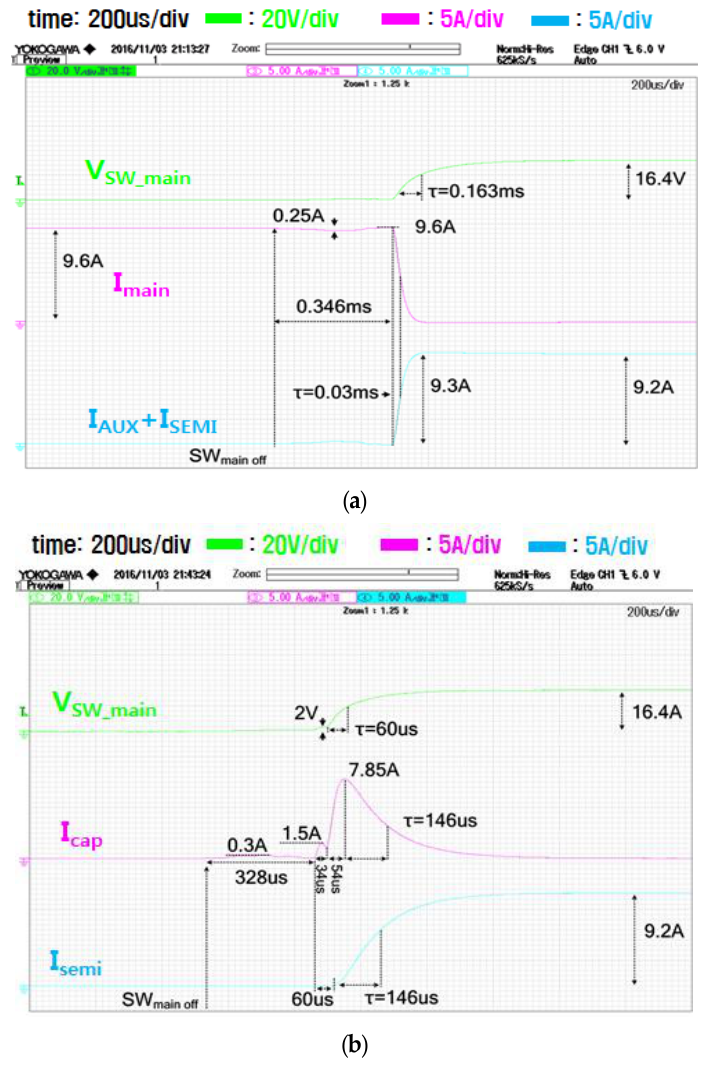
Figure 8. Important current and voltage waveforms during breaking the circuit.